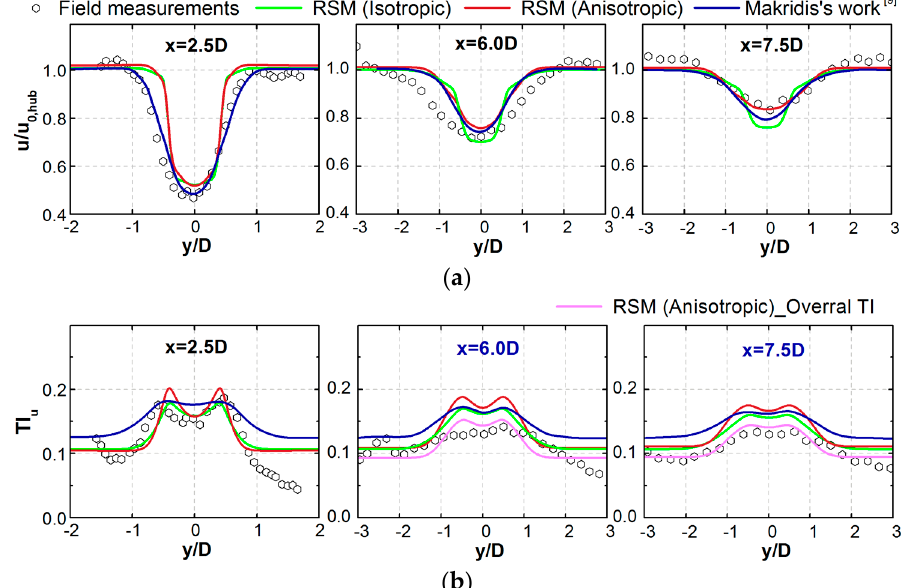
Figure 5. Comparison between the measured and simulated lateral profiles of ( a ) normalized wake velocity and ( b ) stream-wise turbulence intensity at the downstream positions of 2.5 D , 6.0 D , and 7.5 D .